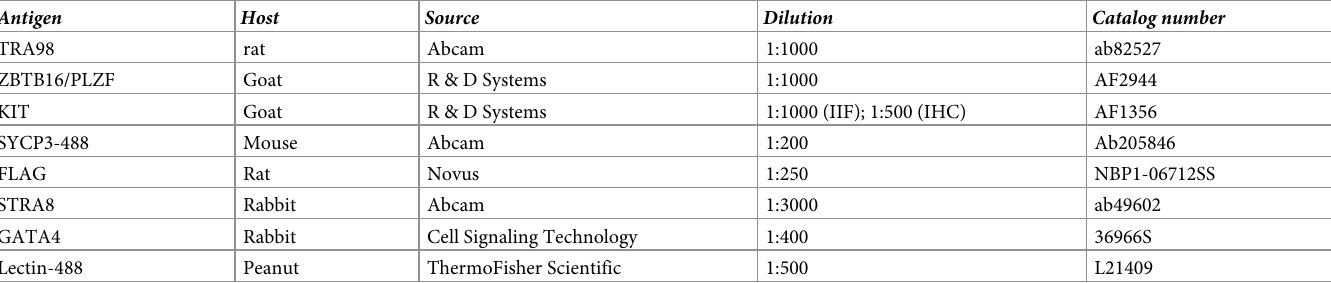
Table 1. Antibodies and immunostaining